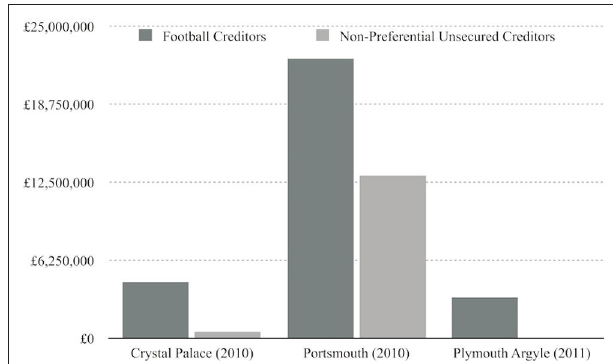
Figure 1: Payments and Football and Non-Football